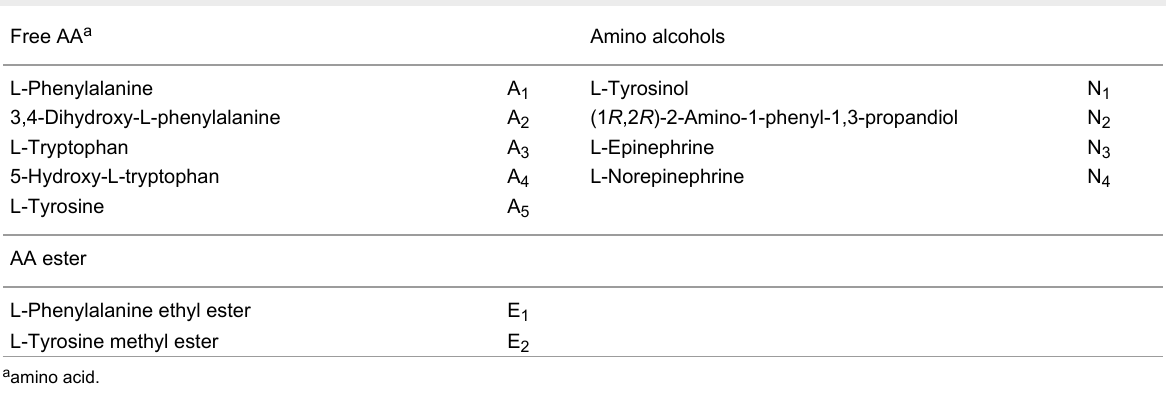
Table 4: Overview of investigated amino acids, amino alcohols and amino acid esters. Free AA a